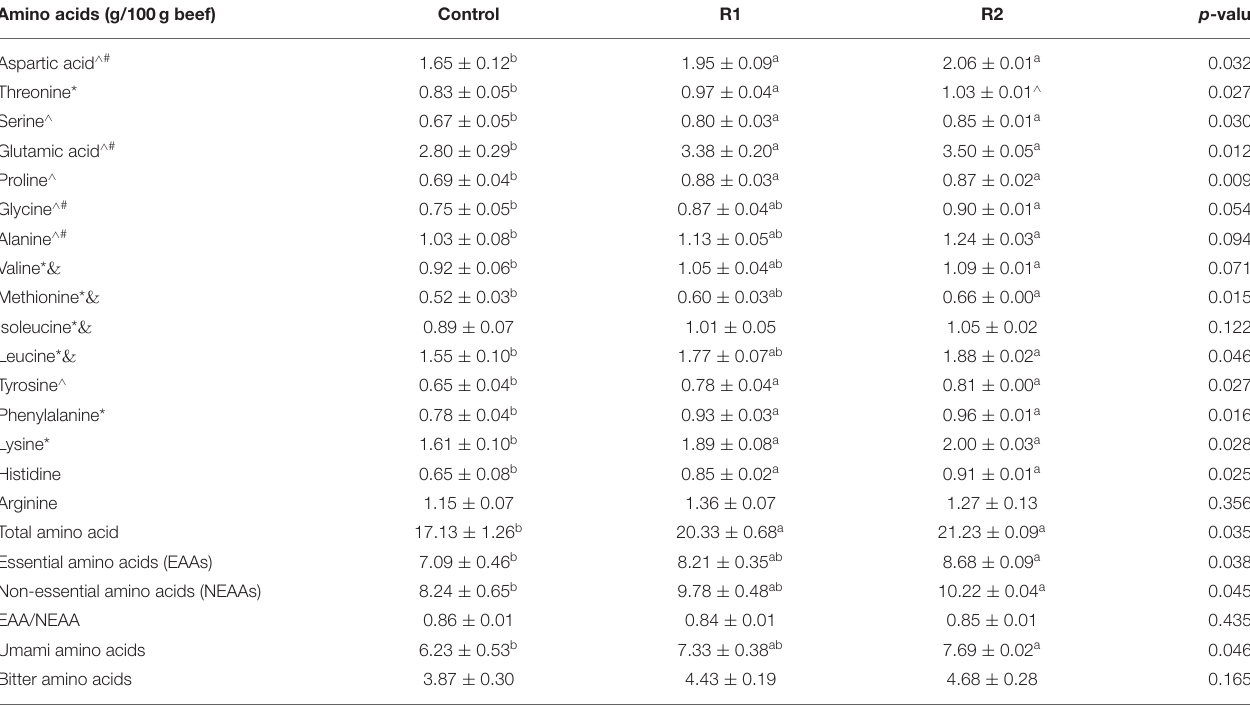
TABLE 4 | Effects of different dietary levels of fermented-Moutai distillers’ grain (FMDG) on the amino acid content of beef. Amino acids (g/100g beef)